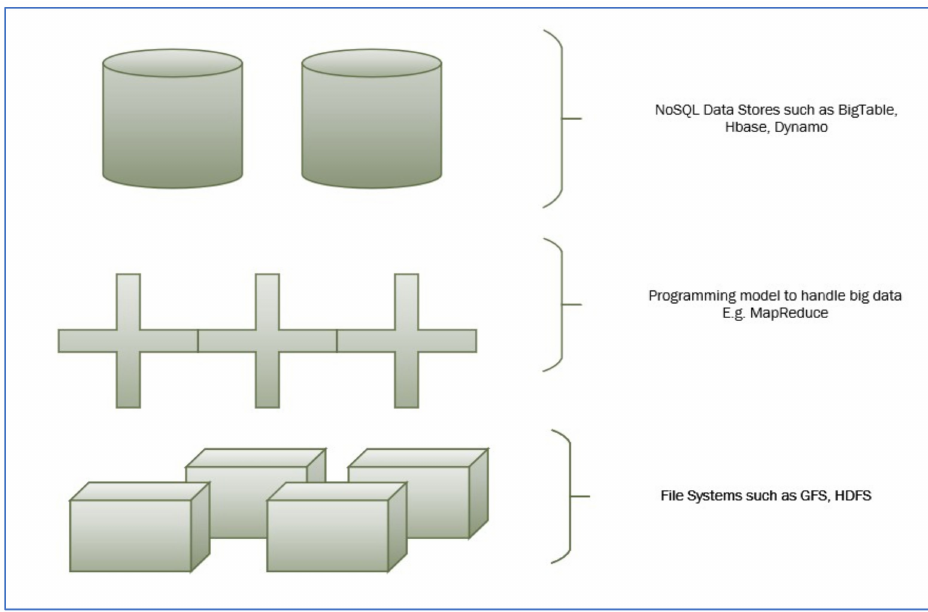
Figure 1. General Layer in Not-Only Structured Query Language (NoSQL) data stores. GFS, Google File System; HDFS. Hadoop Distributed File